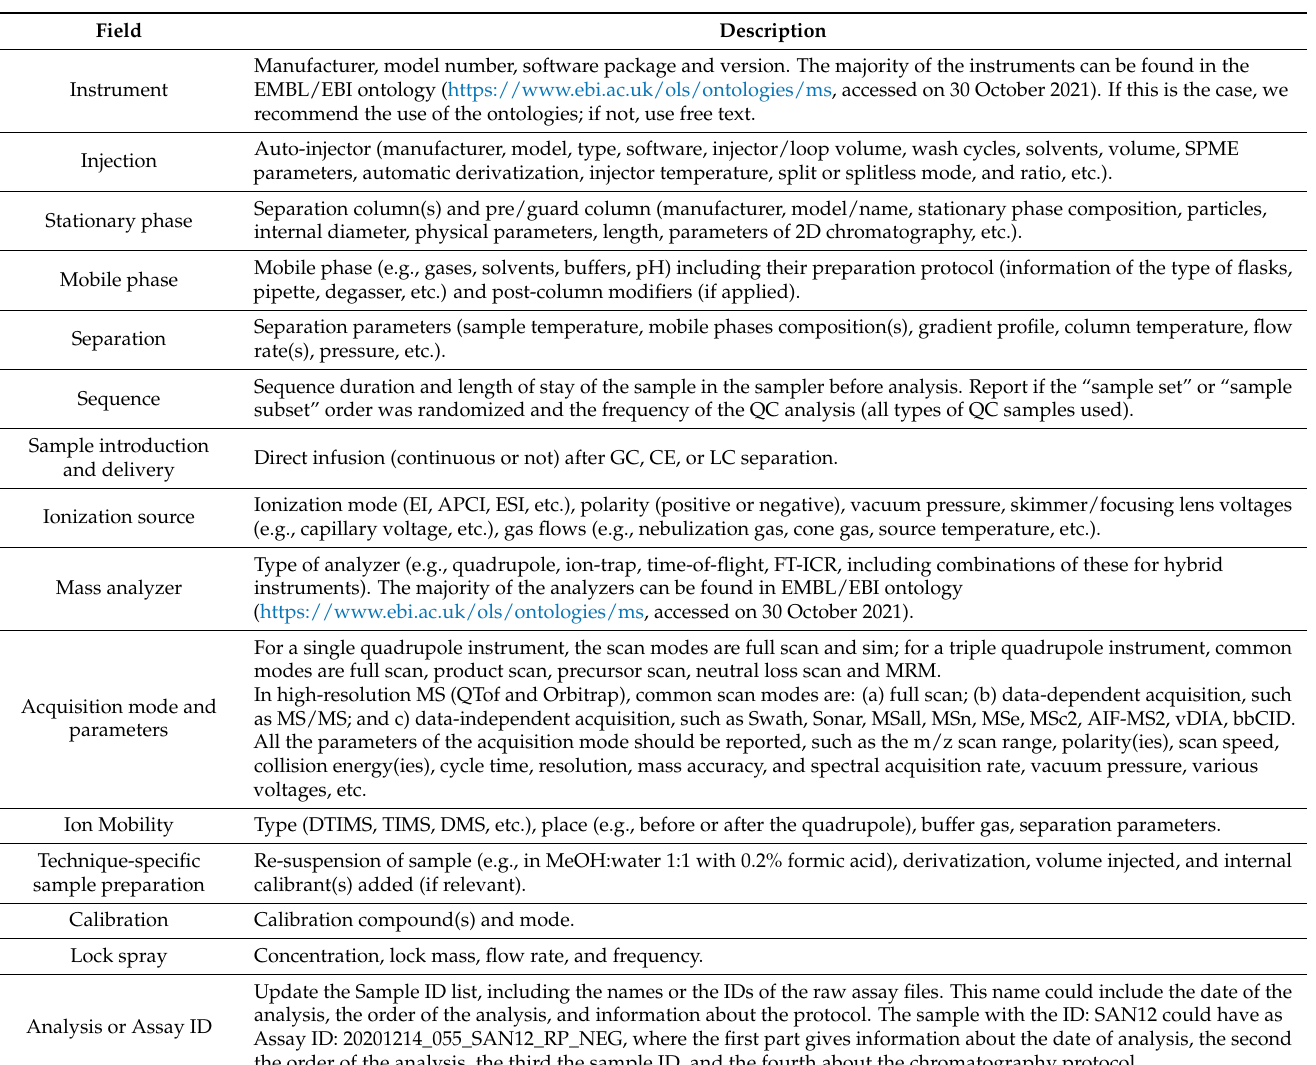
Table 3. Chromatography and Mass spectrometry protocol.